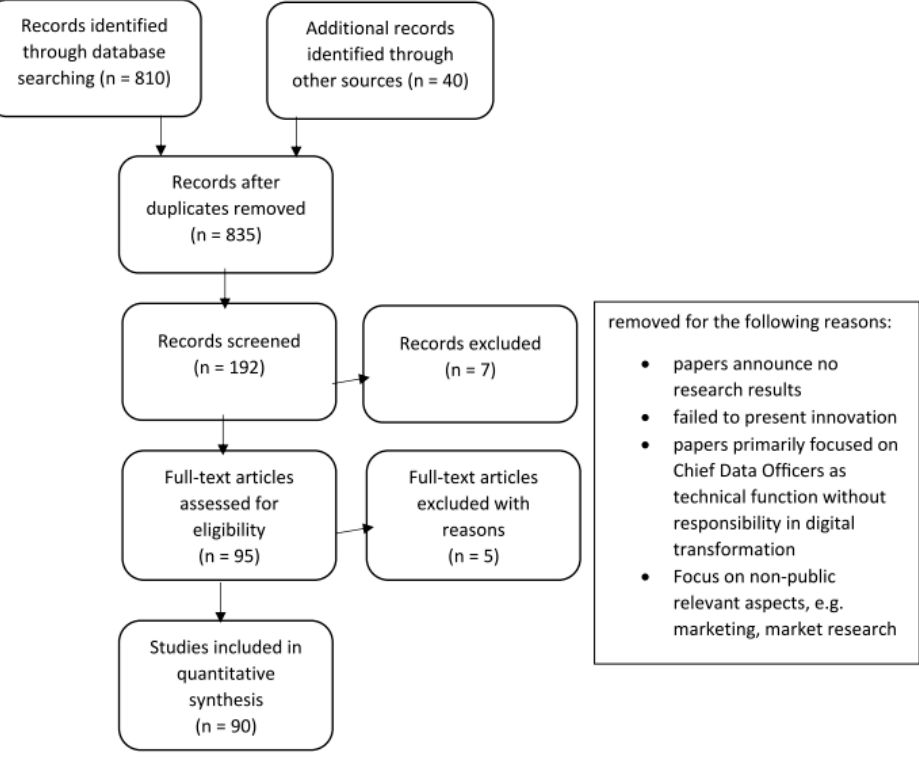
Figure 2. PRISMA Flow Diagram.